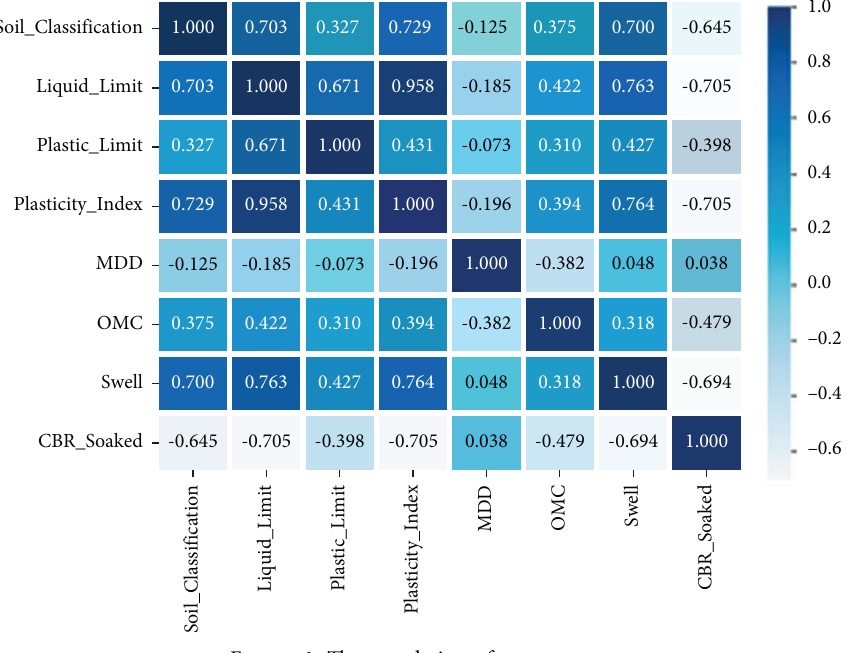
Figure 1: Te correlation of parameters. Table 3: List of parameters in the study.